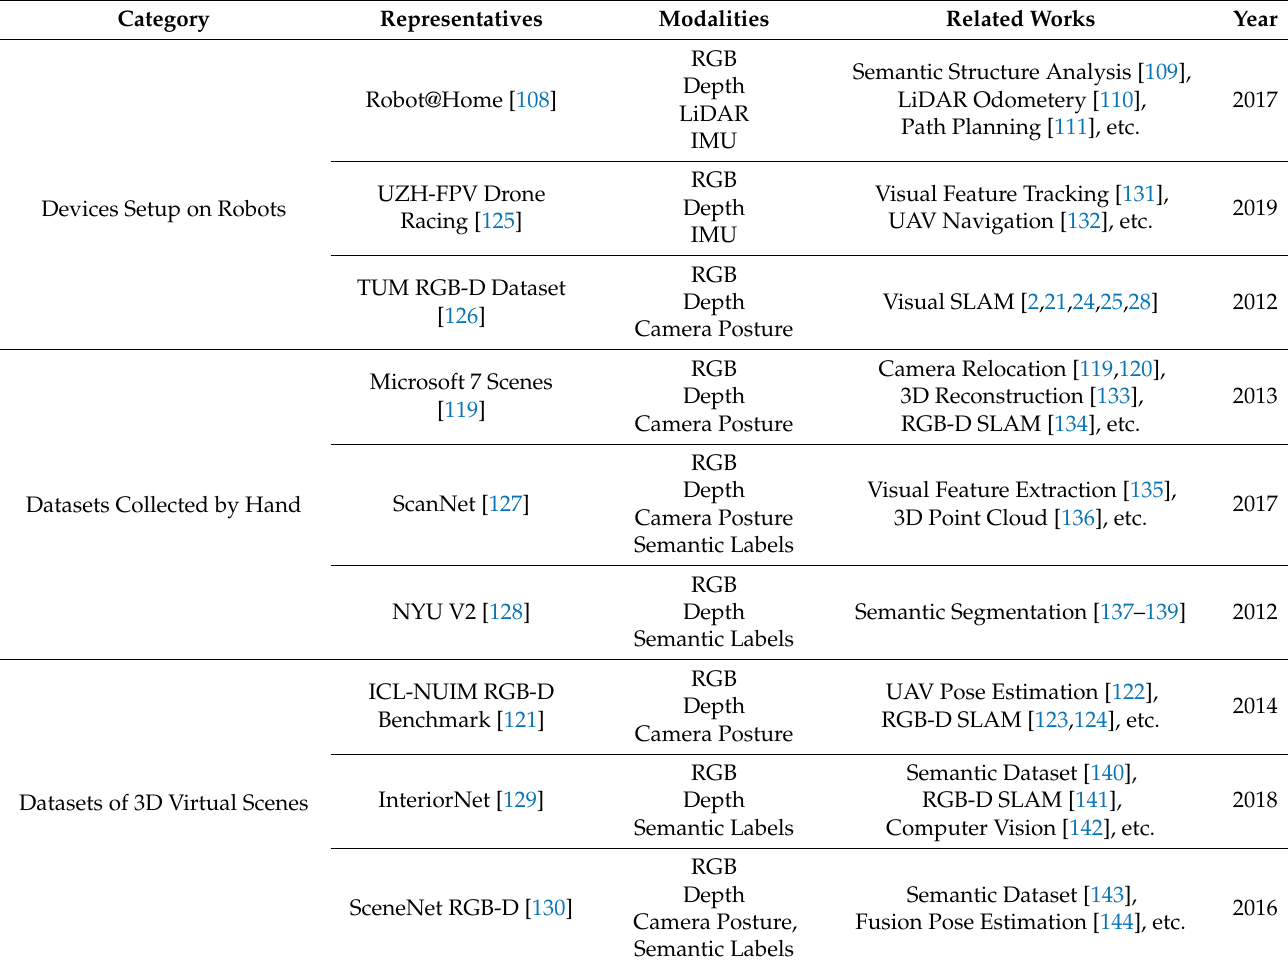
Table 3. A List of Multi-modal